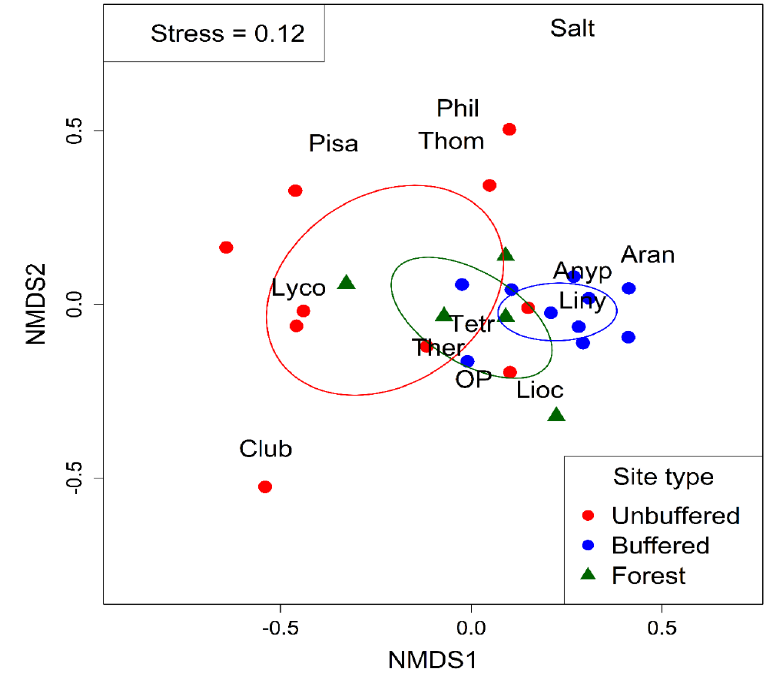
Figure 3. NMDS ordination plot of spider abundances per taxa and site type. Each site is plotted as one point, with points situated closer to one another being more similar in community composition. Association of spider families with the sites is indicated with an overlay of spider family names.